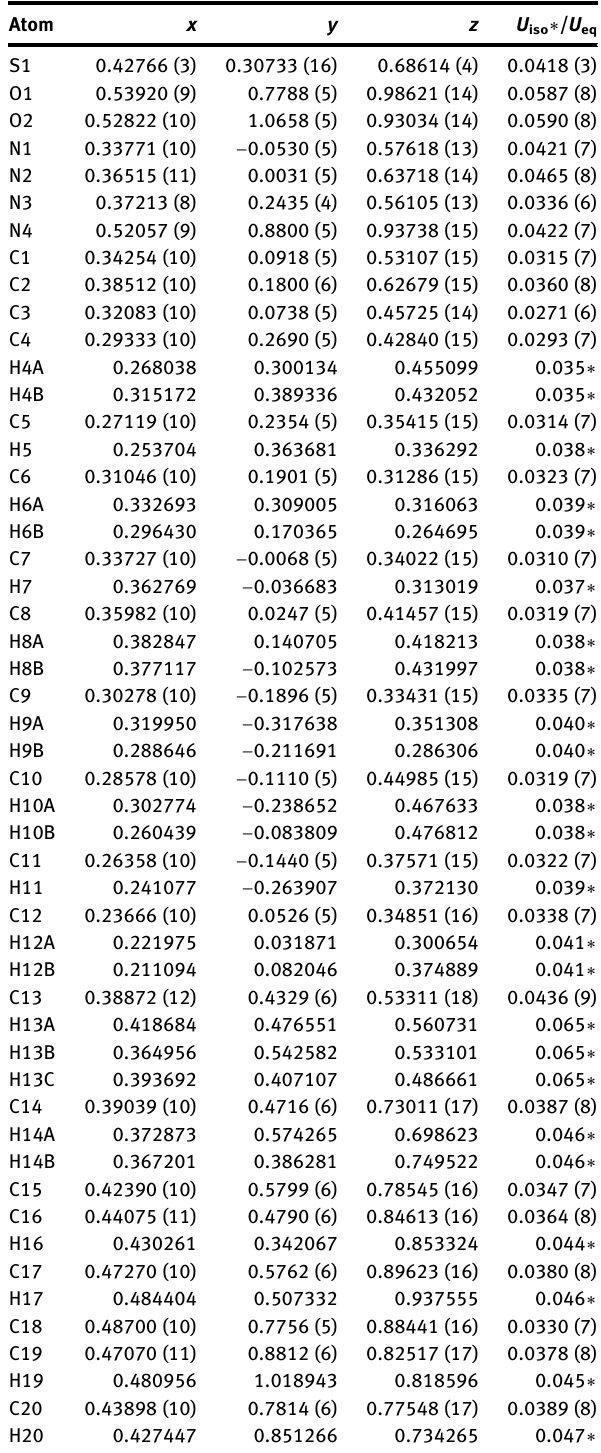
Table  : Fractional atomic coordinates and isotropic or equivalent isotropic displacement parameters (Å 